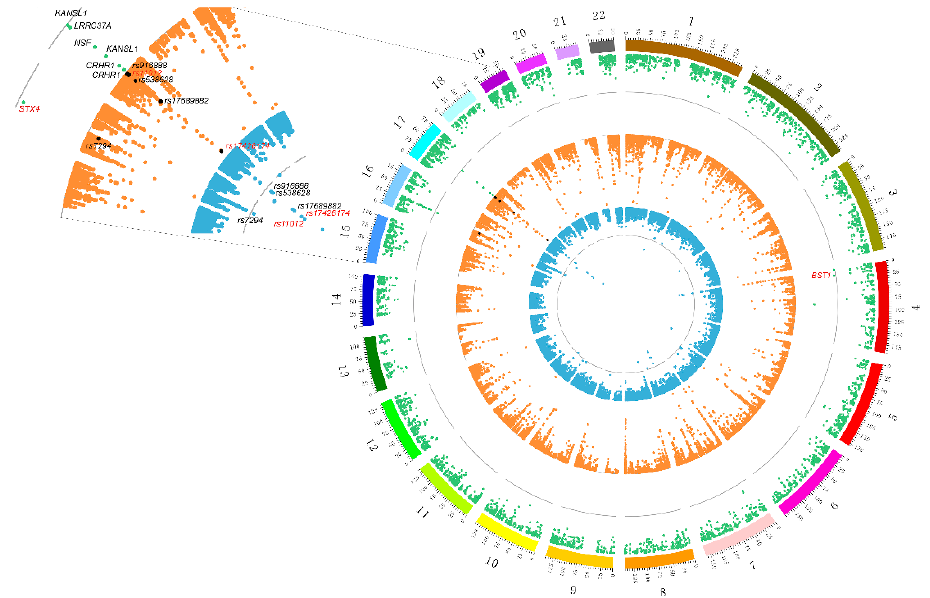
Figure 3. Prioritized risk genes and functional regions of PD with consistent association signals at the multiomics layers. The outermost green represents the results of expression quantitative trait locus (eQTL)-GWAS. Dots that exceed the gray line indicate that they have passed the SMR test. Marked dots represent six pleiotropic genes that passed the HEIDI test (black indicates four known genes; red indicates two new genes). The orange circle in the middle indicates the eQTL-methylation quantitative trait locus (mQTL) results. The innermost blue circle indicates the mutation site of mQTL-GWAS. In these two circles, the mutation sites that passed the SMR and HEIDI were marked, and the red-marked sites were potential mechanism regulatory sites.